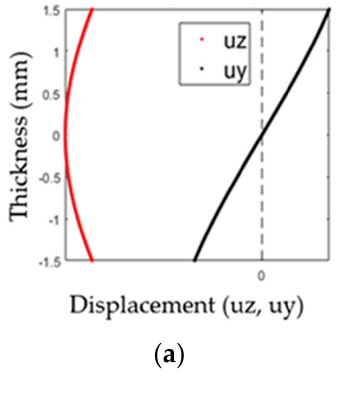
Figure 11. The wave structure of S0 mode at 500 kHz. ( a ) Analytical solution. ( b ) SBFEM isoparametric elements. ( c ) SBFEM spectral elements.